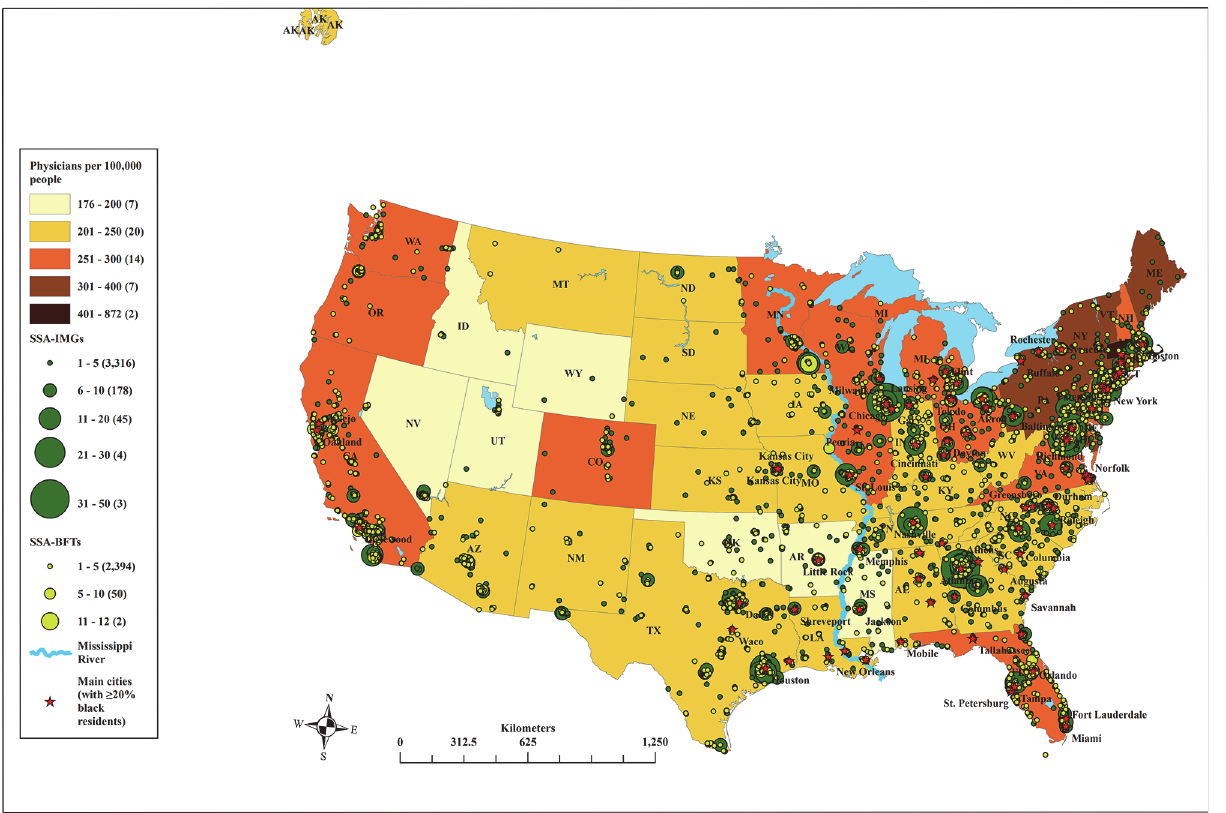
Fig 3. Geography of loss: Spatial distribution of Sub-Saharan African migrant physicians across the United States. Note: SSA-IMGs, international medical graduates trained in Sub-Saharan African-based medical schools; SSA-BFTs, Sub-Saharan African-born, but foreign-trained physicians (i.e., graduates of US and other non-SSA foreign medical schools). Data sources: Redi-Med Data Interactive Medical Database System [51]; Environmental Systems Research Institute [62]; Association of American Medical Colleges [63].